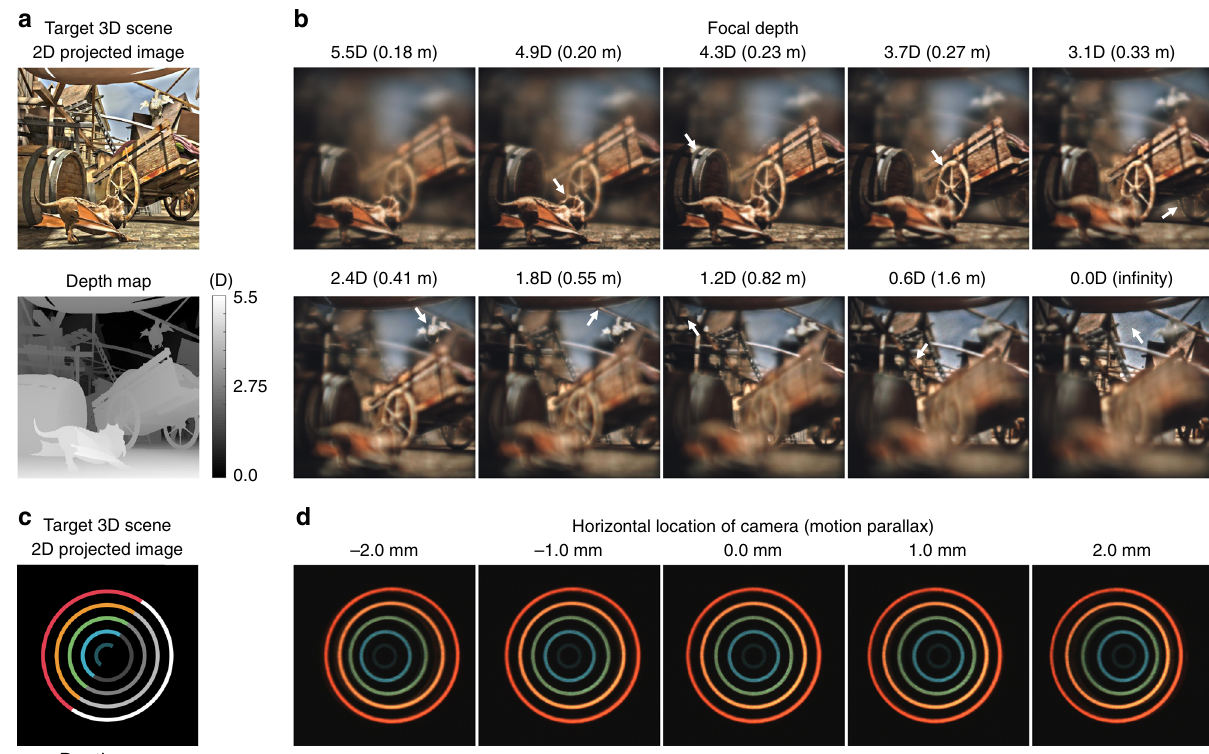
Fig. 2 Experimental results of tomographic near-eye displays. a 2D projected images and the corresponding depth maps are illustrated. The source of 3D content is from the work of Burtler et al. 29 . b Experimental results are demonstrated by ten photographs with different focal depths from a CCD camera. As we can see in the photographs, tomographic near-eye displays may support quasi-continuous focus cues (white arrows) while preserving high resolution and contrast. c , d We demonstrate a brief experiment to show the motion parallax provided by tomographic near-eye displays. Additional results are available in Supplementary Note 6 and Supplementary Movie